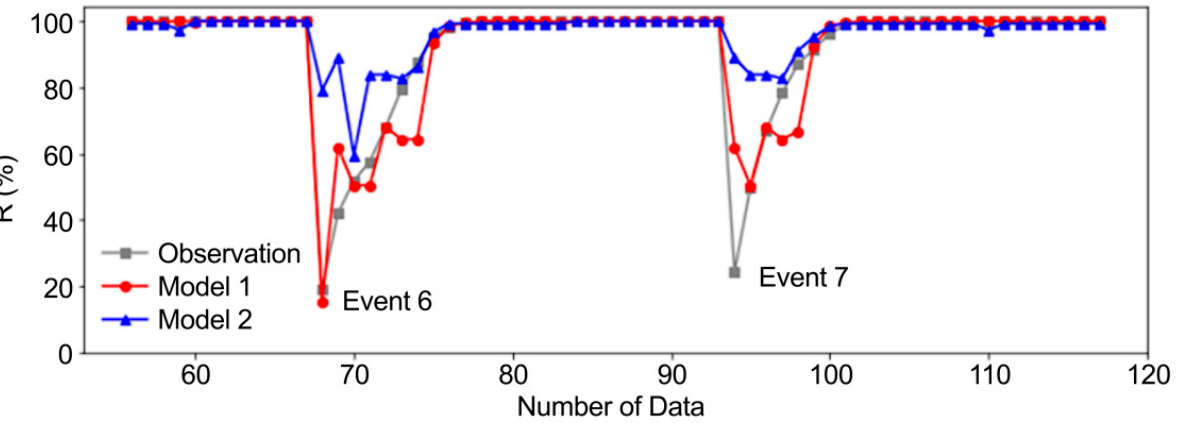
Figure 6. Model prediction of the two disturbance events between 3 March 2021 and 5 March 2021.